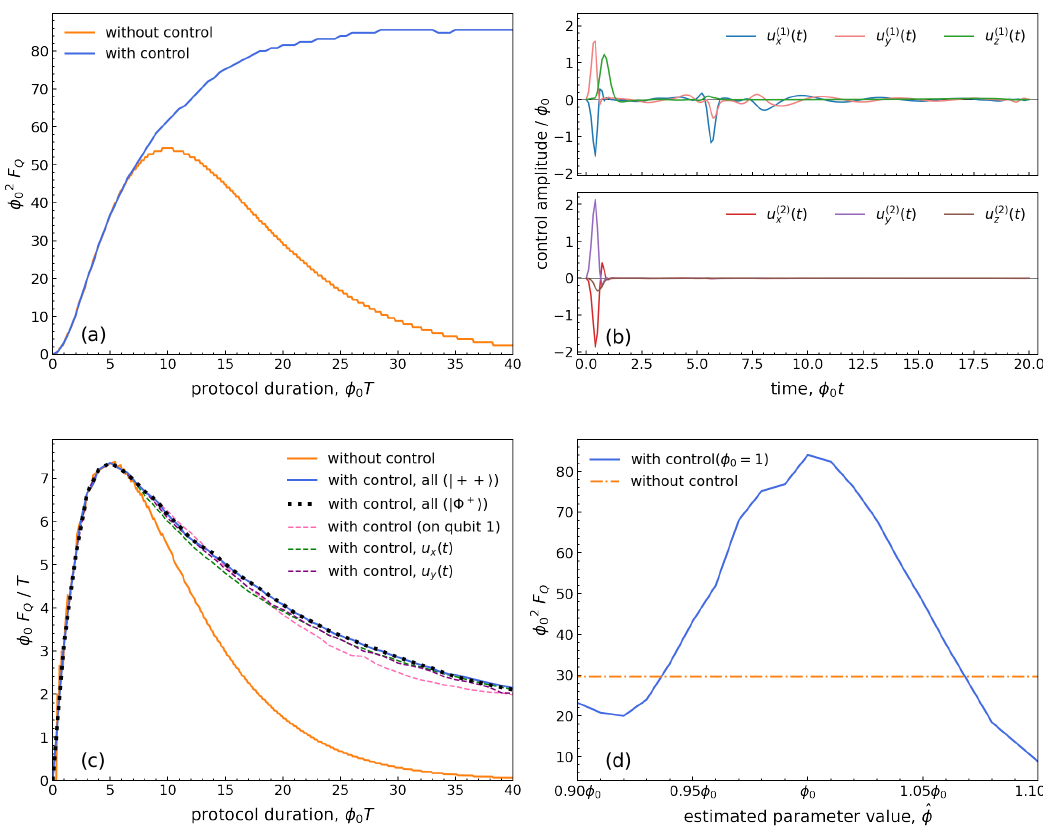
Figure 7: Local frequency estimation for a two-qubit system with ZZ coupling, − 2 φ = 1.0, g = 0.1 and γ = 0.1 (a) The QFI (in units of φ ) achieved without 0 0 − 1 control and with control optimised for target time T (in units of φ ). (b) Optimal 0 controls obtained using Krotov’s method for the dynamics with T = 20. (c) Nor- malised QFI (by T ) without control (orange line), with control on both qubits using (cid:12) + (cid:11) (black dotted a product state | ++ 〉 (blue line) or a maximally entangled state (cid:12) Φ line) as probes, applying controls in all directions only on the qubit with the local ( t ) (green parameter of interest (pink dashed line), on both qubits restricted to u x ( t ) (purple dashed line). (d) The QFI achieved at dashed line) or restricted to u y T = 20 by applying controls optimised with different estimated parameter values ˆ φ on states evolved under the true parameter value φ 0